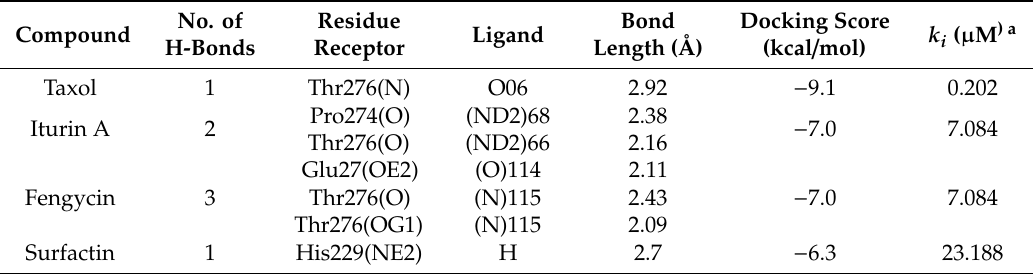
Table 1. Binding affinity for the molecular coupling in the β -tubulin protein complex with taxol and the test lipopeptides.